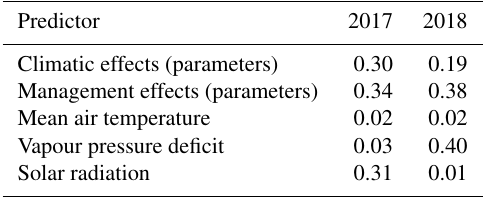
Table 1. Normalised SHAP values for RF-based estimation of an- nual NBE in 2017 and